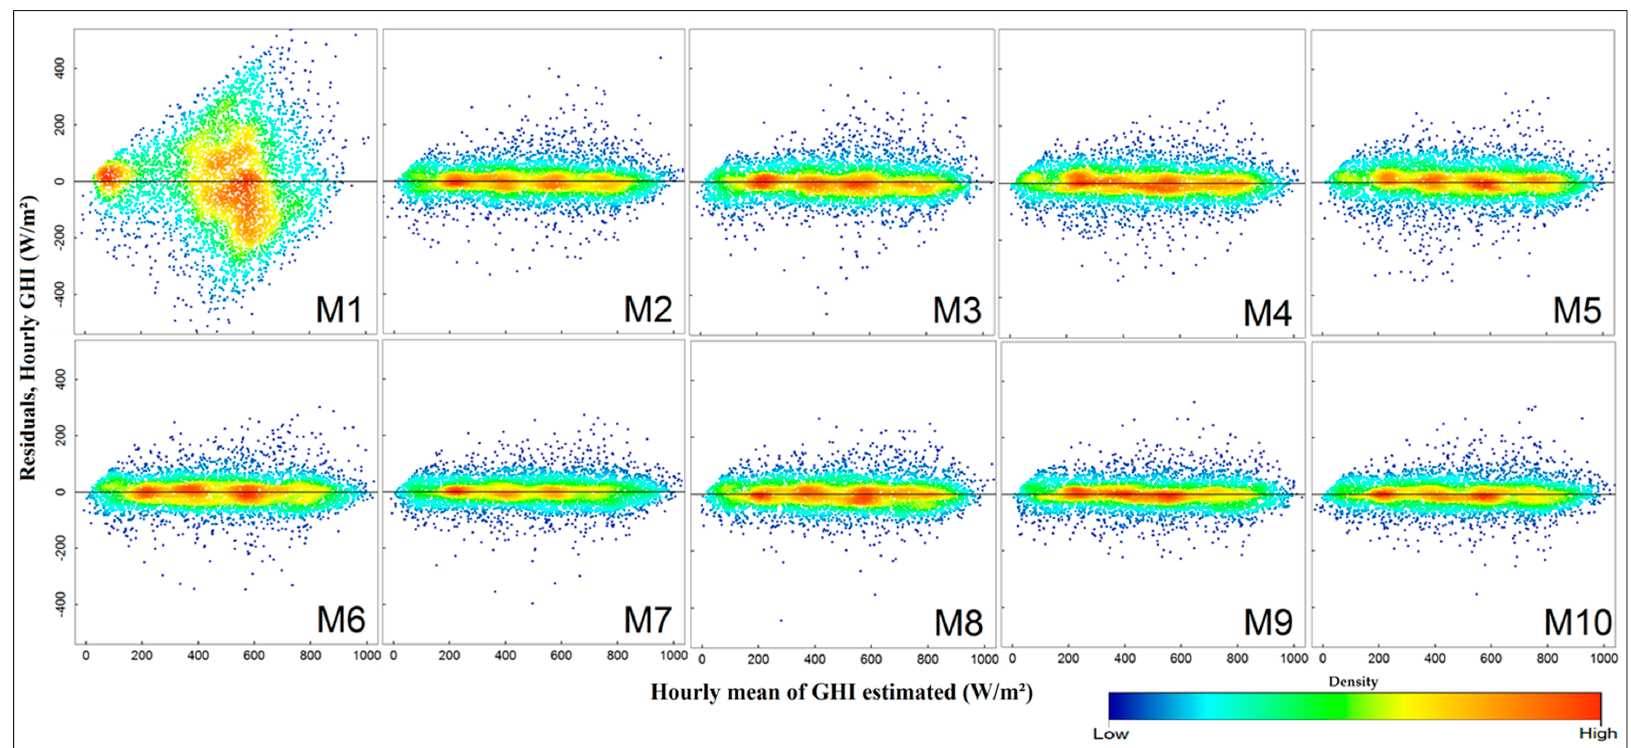
Figure 9. Scatterplots of hourly GHI residuals versus ANN model estimated from M1–M10 at test data for overall results at tower stations. The plots clearly reveal that the models were a good fit for all except M1.